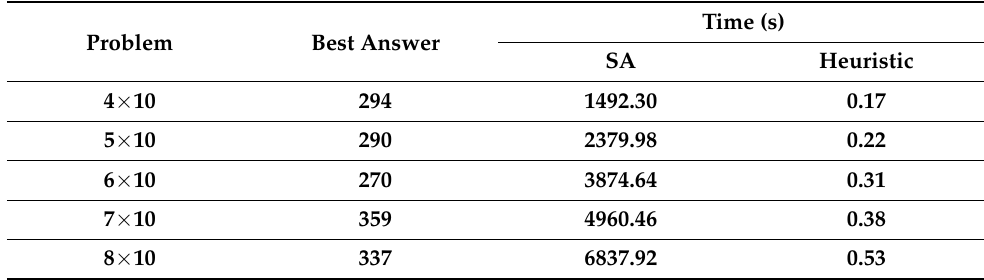
Table 1. Results of executing the SA and heuristic algorithms on various test data (10 ORs).